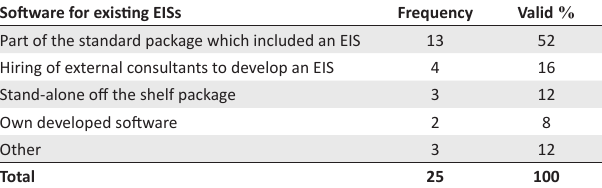
TABLE 3: Software for existing Executive Information Systems (EISs).